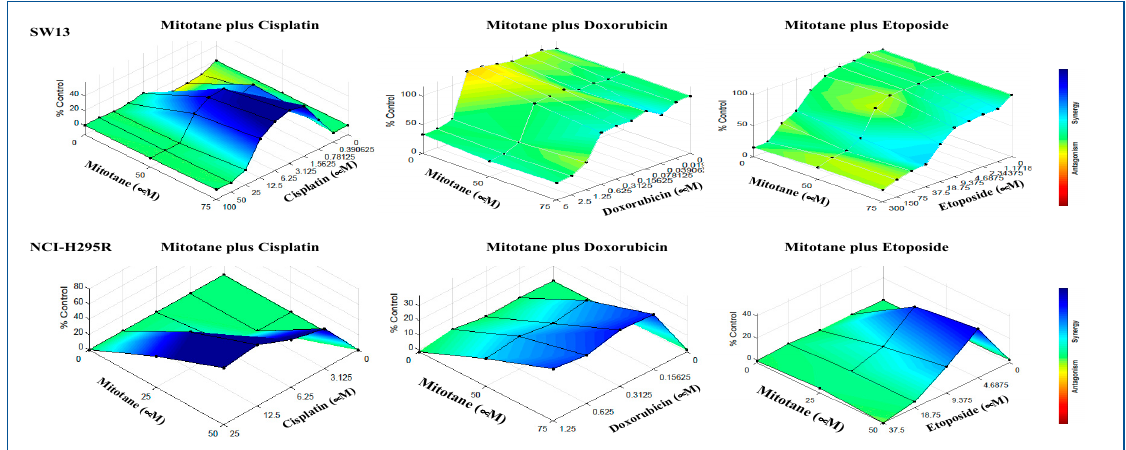
Figure 3. Combenefit analysis showing synergistic combinations of mitotane and one other chemotherapeutic drug (M + P, M + E. and M + D). Surface maps of combination effects plotted using Combenefit software illustrating color coded maps for synergistic/antagonistic effects. Table 1. ACC cell lines NCI-H295R (Left) and SW13 (Right) were treated with varying concentra- tions of chemotherapeutics with or without mitotane for 72 h and the combination Index was calcu- lated using Chou-Talalay equation. C < 1 is synergistic, C = 1 additive, and C > 1 is antagonistic (Red text).